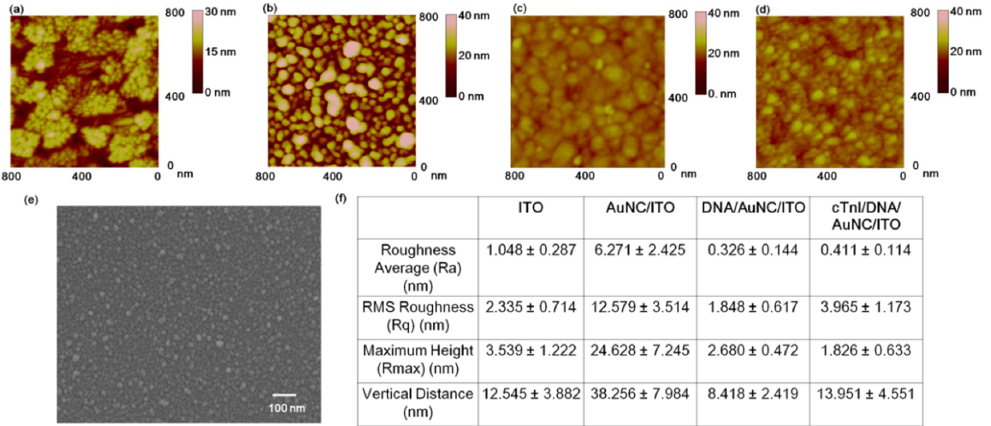
Figure 2. AFM data for the surface morphology investigation, ( a ) Indium-tin-oxide (ITO) substrate, ( b ) AU nanocluster (AuNC)-deposited ITO substrate, ( c ) DNA 3 way junction (3WJ)-modified AuNC-deposited ITO substrate, ( d ) cTnI / DNA 3WJ / AuNC-modified ITO substrate, ( e ) Surface roughness analysis values of the ITO, AuNC on ITO, DNA 3WJ-modified AuNC-ITO substrate and cTnI on DNA 3WJ / AuNC-ITO substrate, ( f ) Surface roughness analysis of the ITO, AuNC / ITO, DNA 3WJ / AuNC / ITO and HA protein / DNA 3WJ / AuNC /ITO.